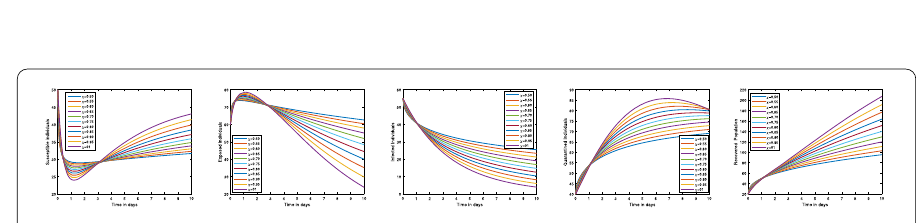
Figure 2 Profiles for the first set of initial conditions at different χ values i.e. χ = 0.50,0.55,0.60,0.65,0.70, 0.75,0.80,0.85,0.90, and α = 0.2